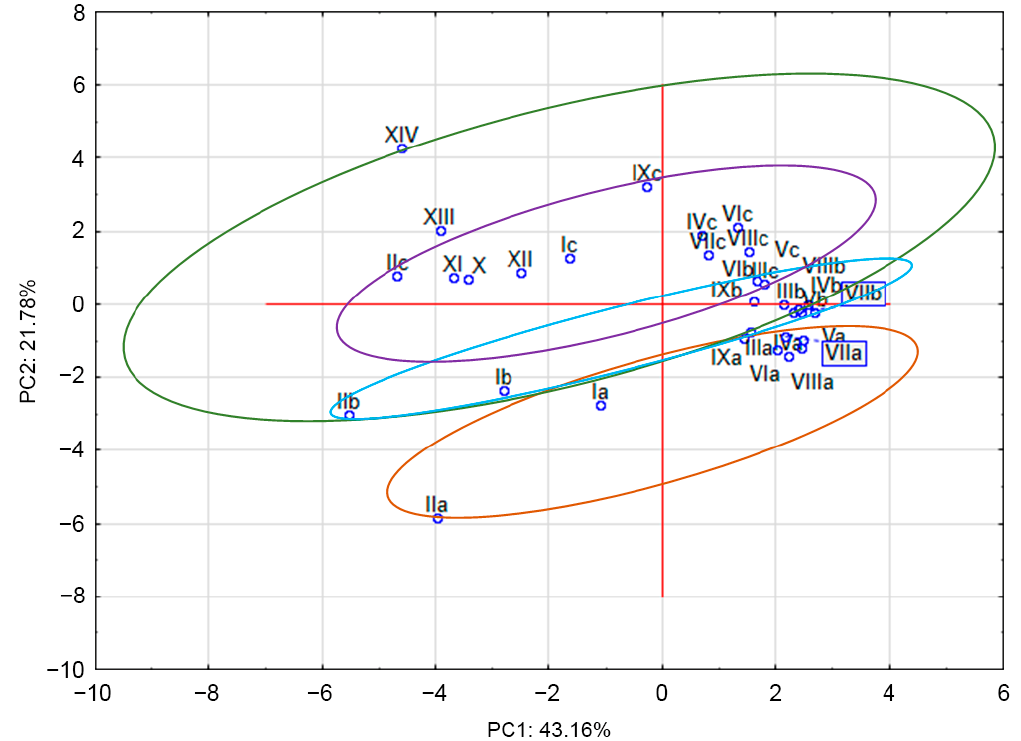
Figure 2. PCA of fresh nettle leaves (samples Ic–IXc), stems (Ib–IXb), aerial parts (leaves with stems X–XIV), and roots (samples Ia–IXa).